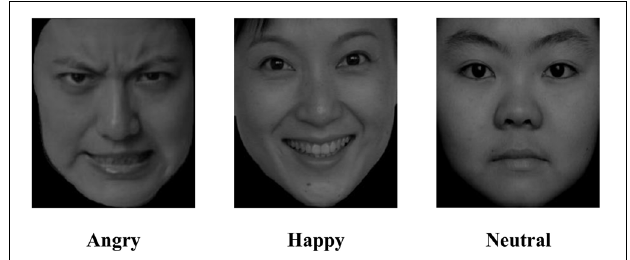
FIGURE 1 | Sample face pictures of different emotional valences.